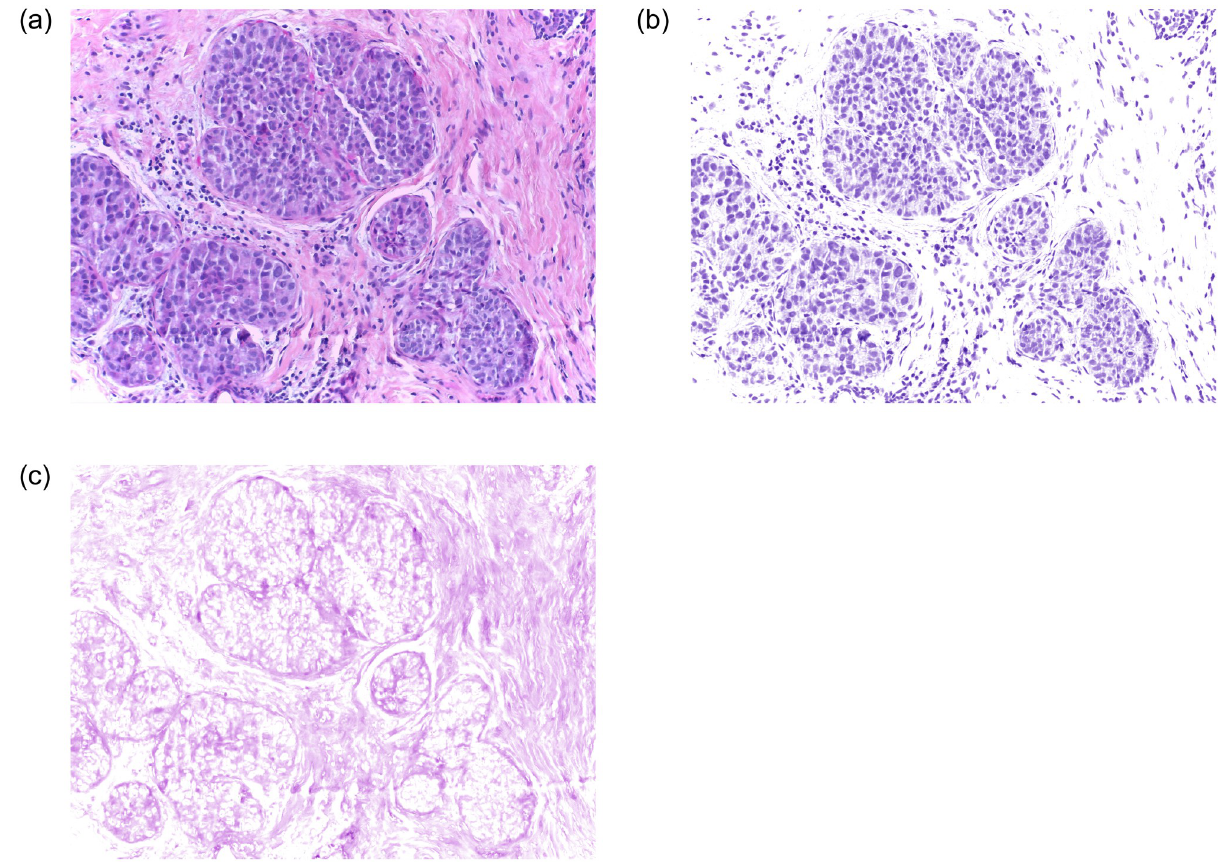
Fig 2. Stain separation results of breast cancer histopathological images. (a) Original image, (b) Fore ground image of stain separation, (c) Back ground image of stain separation.